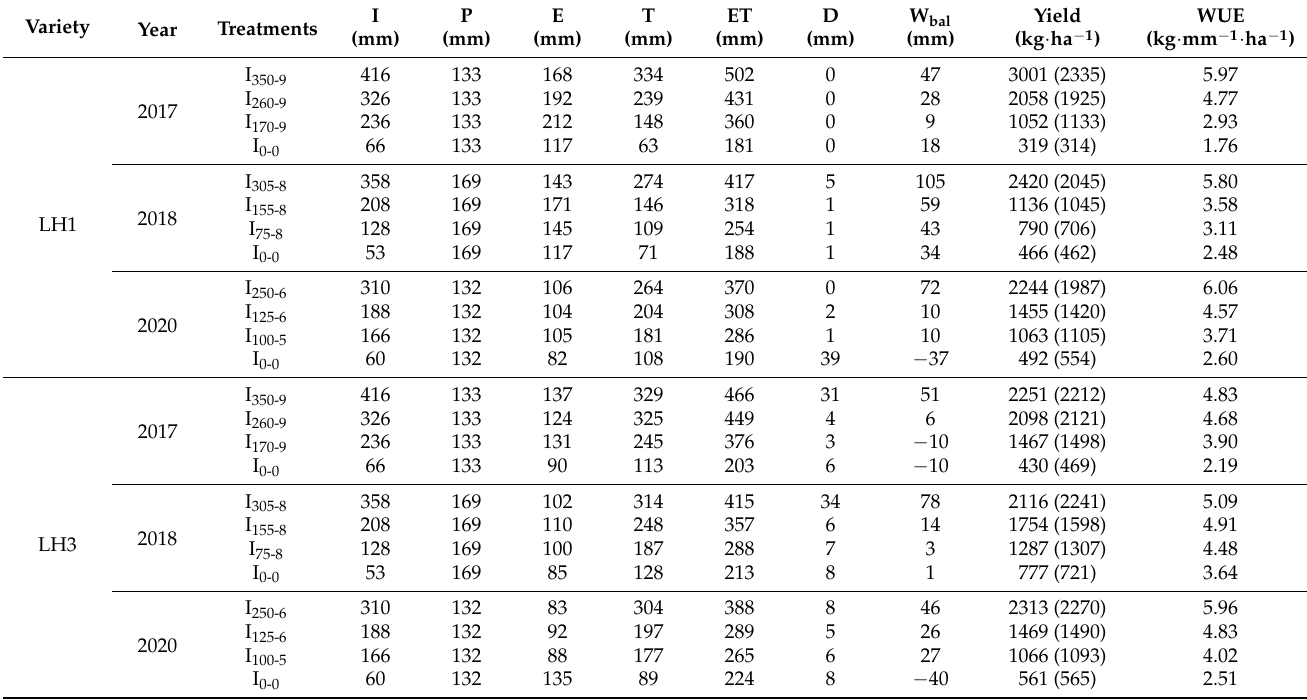
Table 5. Water balance of 0–100 cm of the soil profile and water use efficiency of LH1 and LH3 in 2017, 2018 and 2020 simulated by